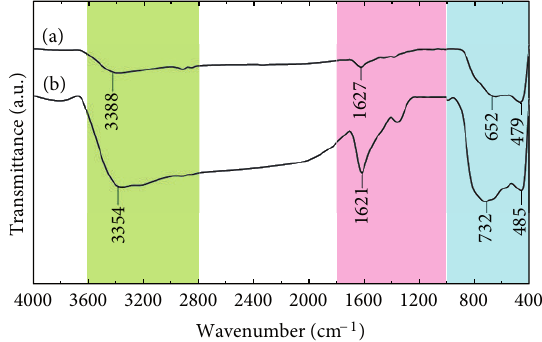
F 6: e Ultraviolet visible spectra for samples A and B of TNPs ((a) and